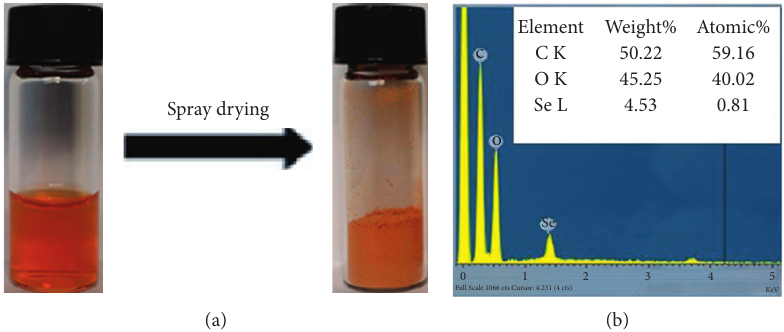
Figure 6: SeNPs/OCS in powder form prepared by spray drying (a) and EDX spectrum of the SeNP/OCS powder (b).